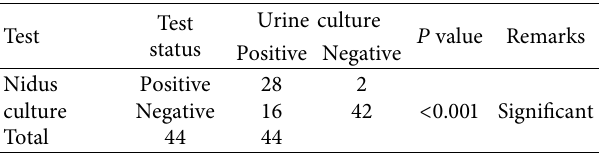
Table 2: Association of bacteria isolated from urine and stone matrices